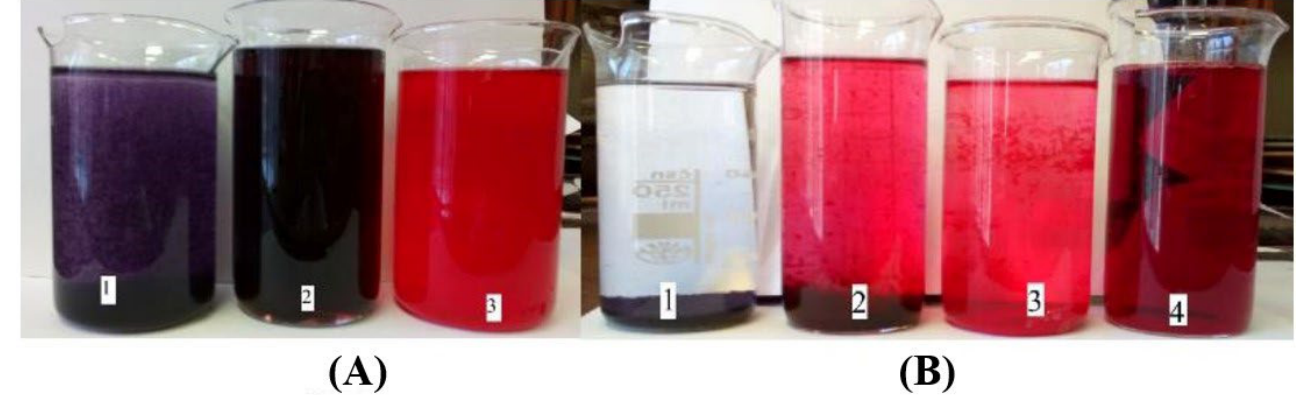
Figure 8. Dependence of the removal efficiency of CR from an aqueous solution on pH. ( A )—CR solution after 1 min of extraction at pH = 3 ( 1 ), 7 ( 2 ), and 11 ( 3 ). ( B )—CR solution one day after reaching equilibrium of the solid-phase extraction at pH = 3 ( 1 ), 7 ( 2 ), and 11 (3 ). ( 4 )—Initial solution. To describe the adsorption of dyes using the synthesized sorbent, a pseudo first-order kinetic model was used, the compliance of which was confirmed by regression analysis using the least squares method (Figure 9). The pseudo first-order adsorption rate constants calculated by the graphical method are shown in Table 1.